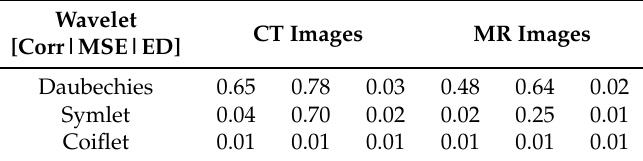
Table 3. Distribution of p-values of Mann-Whitney test for the Gaussian and Salt and Pepper